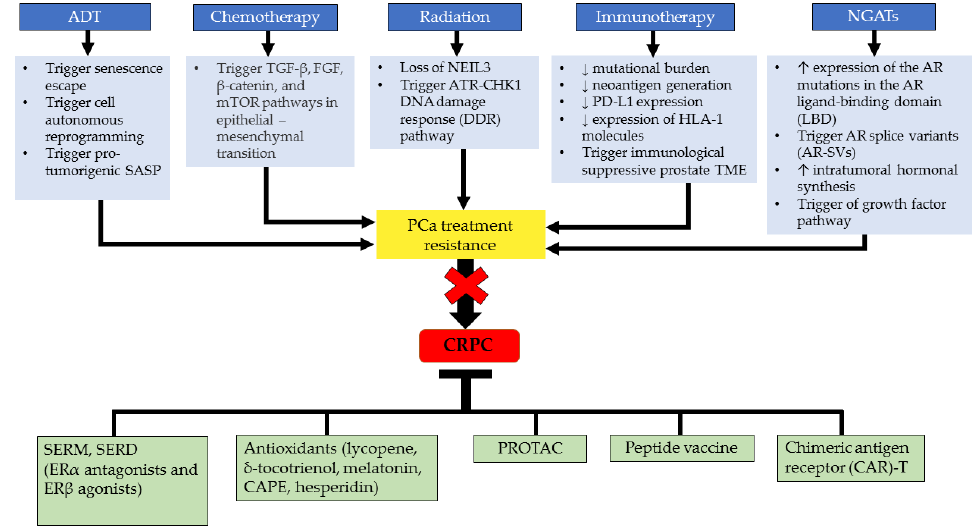
Figure 3. Therapeutic approaches for inhibiting CRPC progression as an alternative in mitigating the treatment resistance that occurs in CRPC. Abbreviations: ADT, androgen-deprivation therapy; CRPC, castration-resistant prostate cancer; AR, androgen receptor; DNA, deoxyribonucleic acid; NGAT, next-generation anti-androgen therapy; PCa, prostate cancer; LBD, ligand binding domain; TGF β , transforming growth factor beta; FGF, fibroblast growth factor; mTOR, mammalian target of rapamycin; AR-SV, androgen receptor-splice variant; SERM, selective estrogen receptor modulator; SERD, selective ER downregulator; CAPE, caffeic acid phenethyl ester; PROTAC, proteolysis targeting chimeras; CAR-T, chimeric antigen receptor (CAR)-T cell treatment.